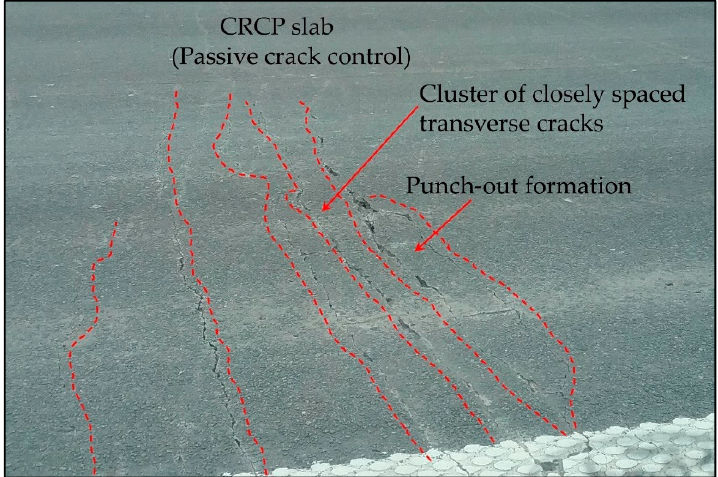
Figure 3. Passive crack development on the Motorway E17 section.